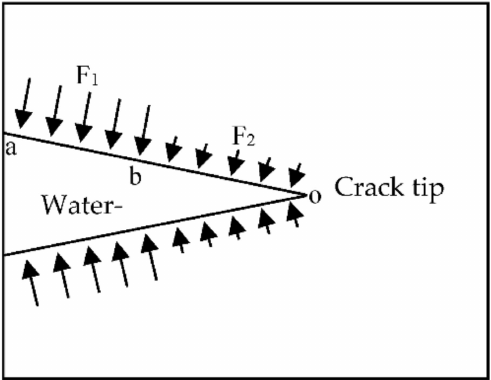
Figure 9. Bernoulli effect of